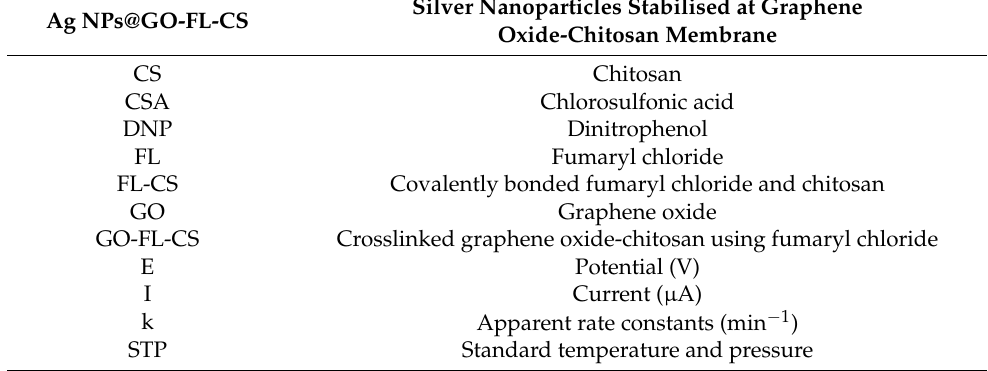
Table 1. List of acronyms and